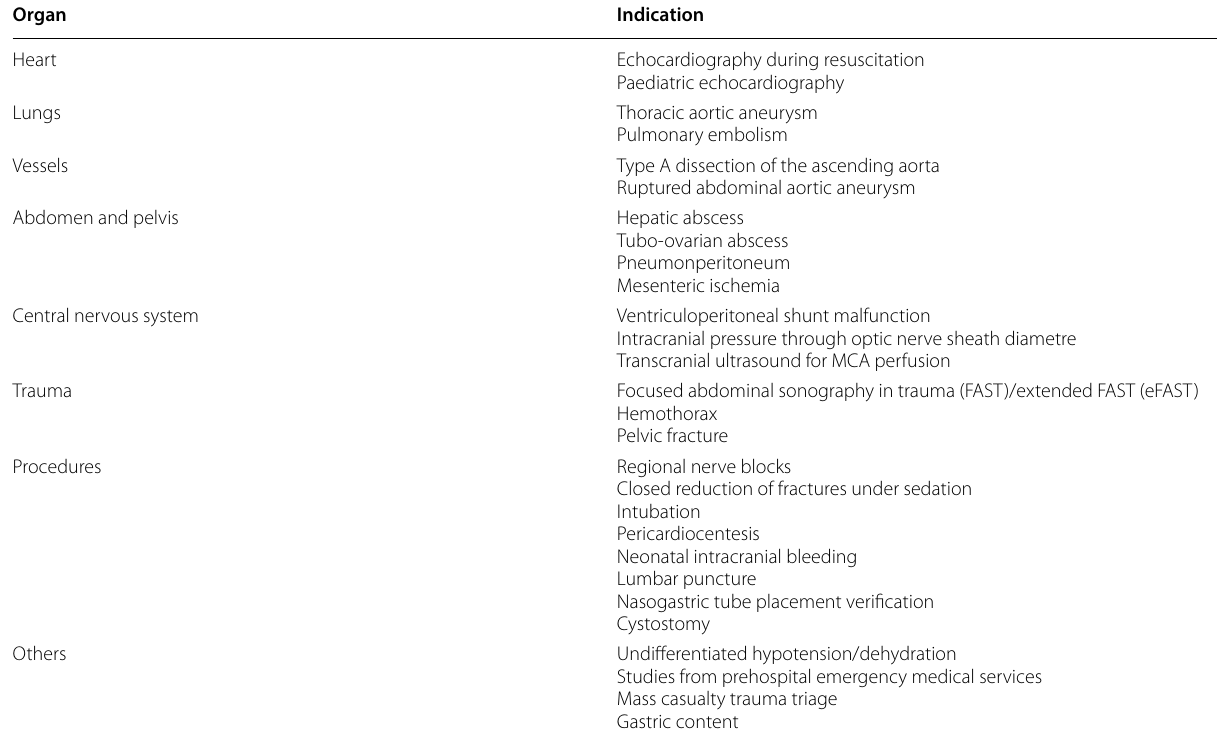
Table 9 Indications excluded due to less relevance for general practice